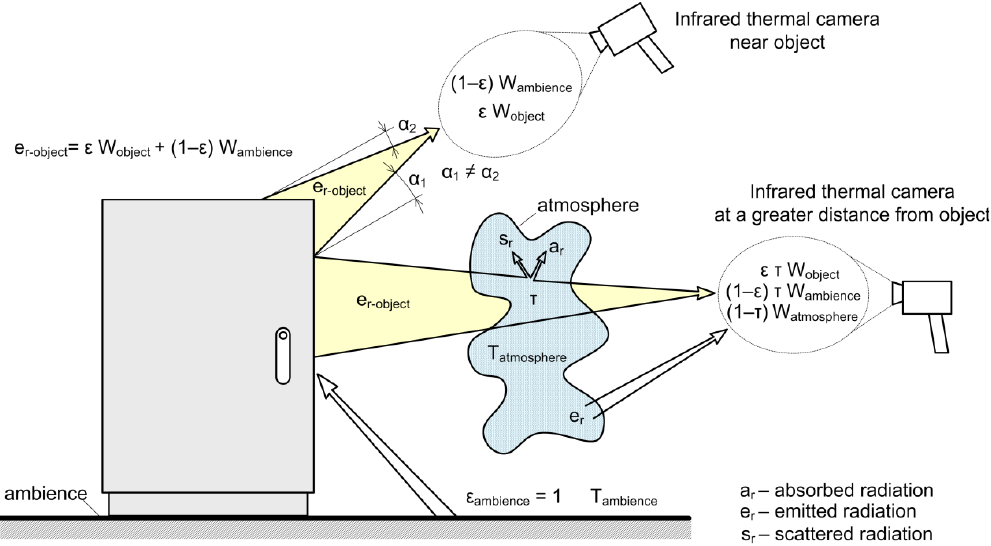
Figure 14. Components of radiation detected by the infrared thermal camera.